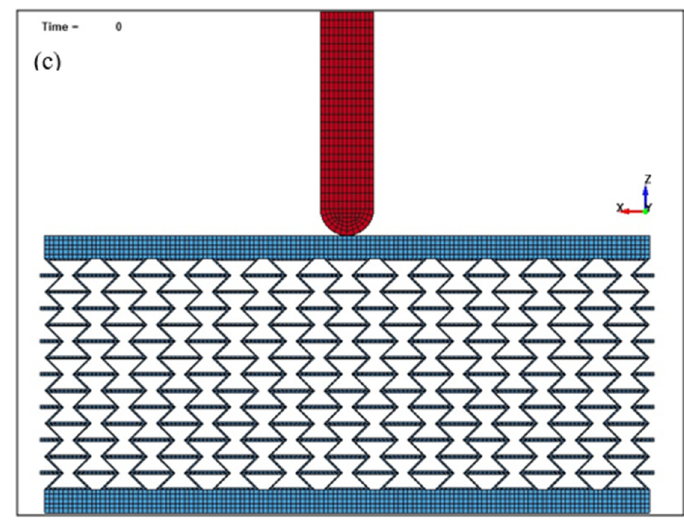
Figure 5. ( a ) A typical stress–strain diagram of NiTi shape memory alloy (SMA), ( b ) isometric view of the meshed model, and ( c ) front view of the meshed model.